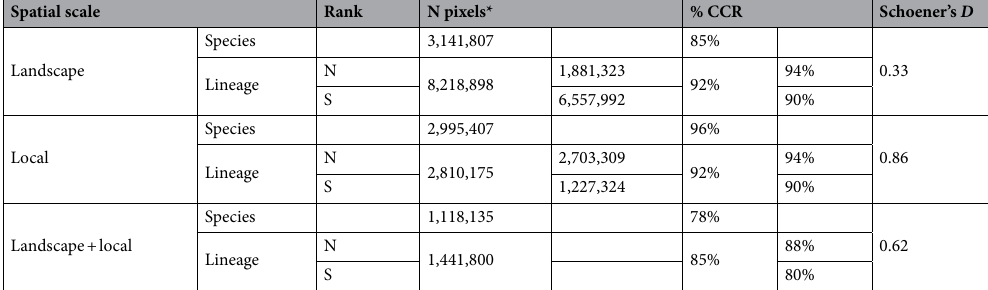
Table 3. The number of suitable pixels (30 × 30 m) predicted by each model (N pixels), the percentage of correct classification of occurrence records by each lineage-/species-level model based on minimum training presence cut-off threshold (% CCR), and Schoener’s D prediction at the two evolutionary ranks. *Northern and southern lineages are shared some areas (pixels).